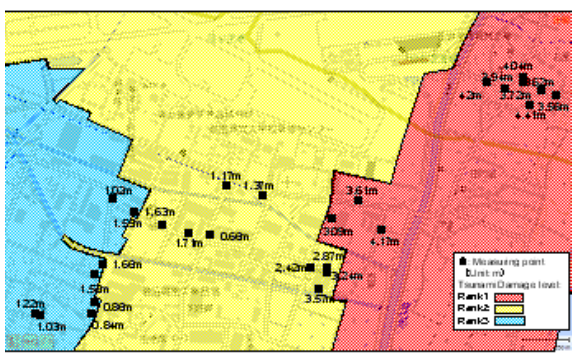
Figure 5. Tsunami flooded depth measured by MMS at Sendai Airport area